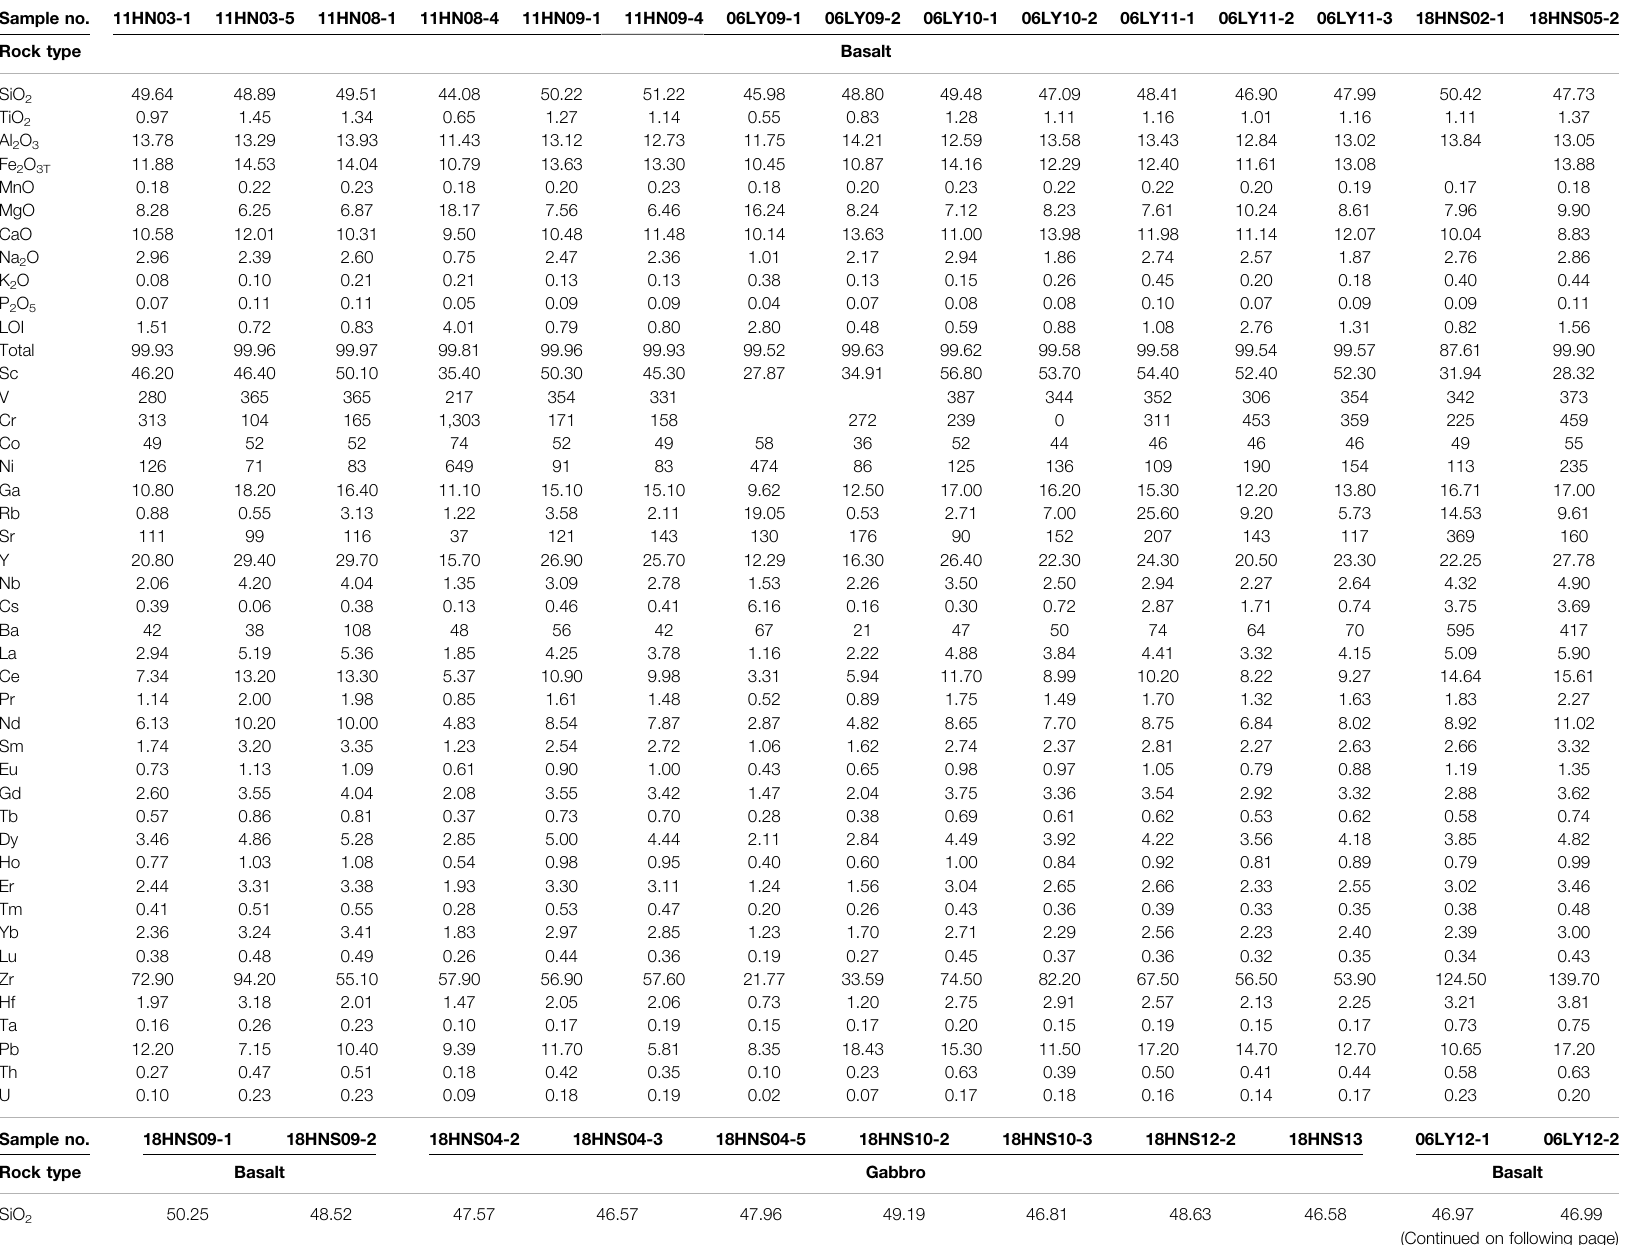
TABLE 3 | Major (wt%) and trace element (ppm) results for the Huaniushan complex in the Beishan orogen, NW China.